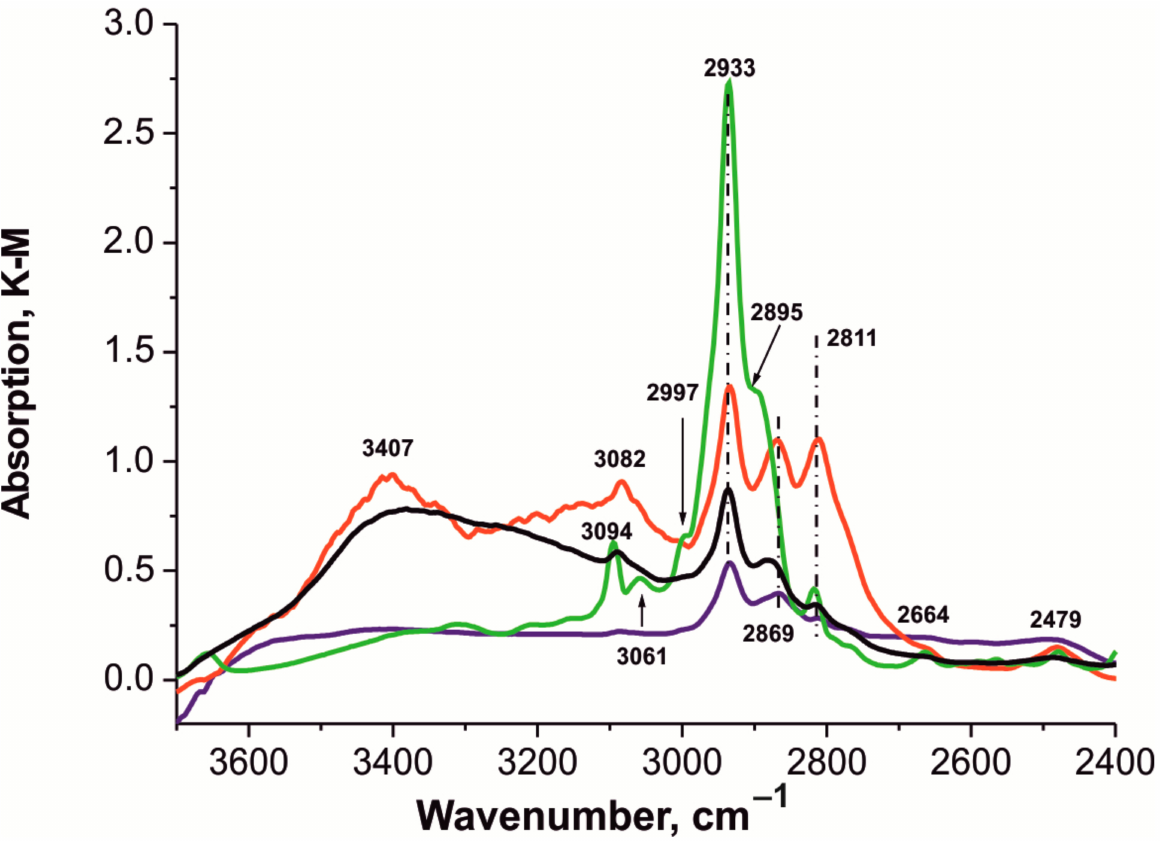
Figure 7. DRIFT spectra of the 1 (black), 2 (red), and 3 (blue) composites and the HKUST-1 mw reference sample (green) in the frequency range of 3700–2400 cm − 1